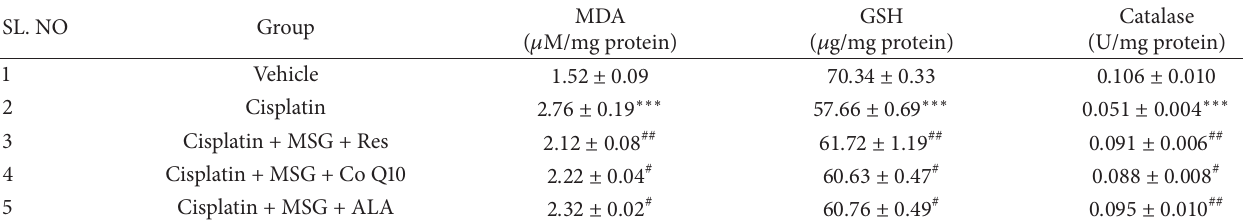
Table1:EffectofchronictreatmentwithcombinationofMSGandresveratrol/ALA/CoQ10onlevelsofMDA(amarkeroflipidperoxidation), reduced glutathion, and catalase in sciatic nerve of cisplatin treated rats. SL.